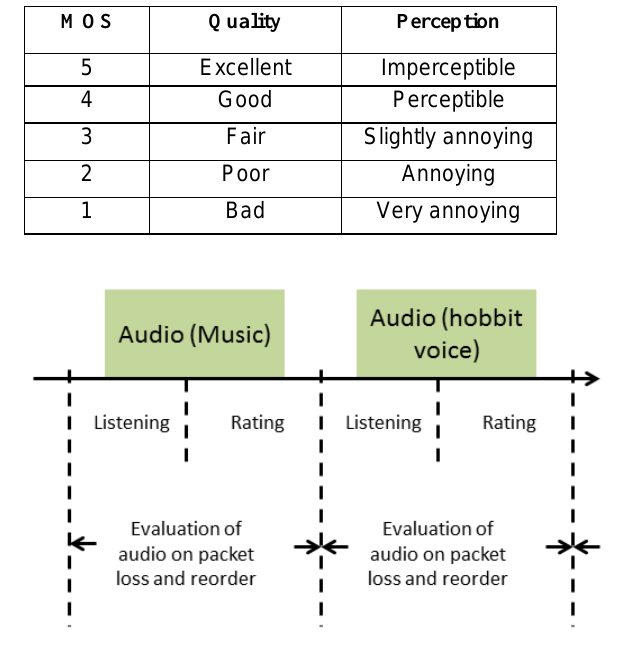
Figure 2. ACR experimental